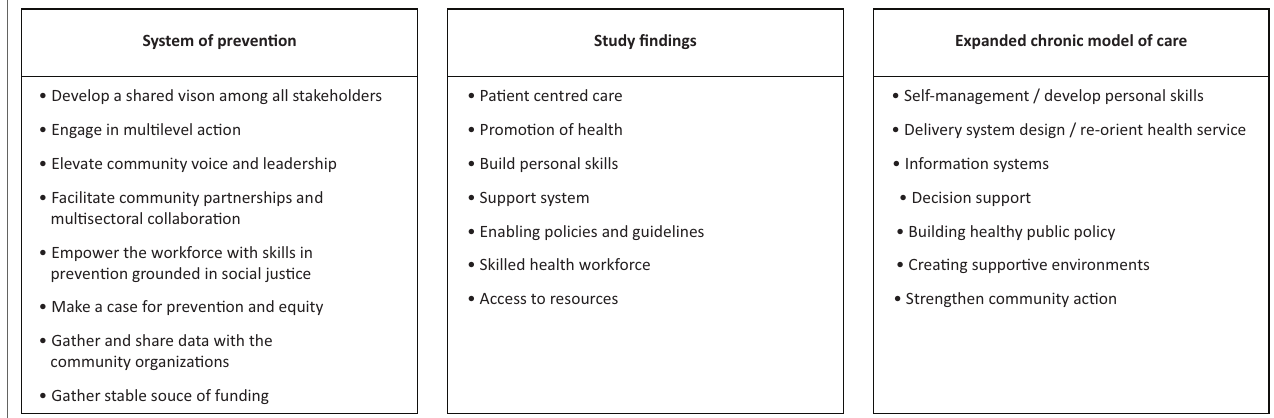
FIGURE 3: Comparison between the emerged themes and the elements from the expanded chronic care model and the system of prevention